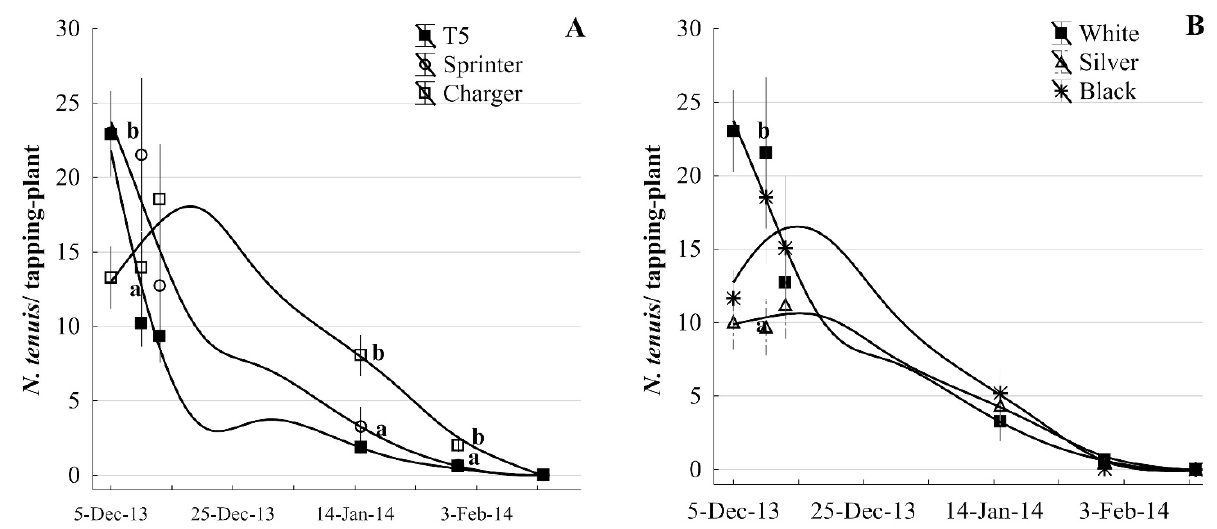
Figure 7. Effect of tomato cultivar and plastic color cover on N. tenuis population (mean ± SE): ( A ) Cultivar evaluation and ( B ) row mulch color evaluation. Means followed by different letters on a date are significantly different ( p ≤ 0.05, ANOVA and Fisher’s HSD). The moving mean curves shown with lines were fitted by a distance-weighted least squares method.